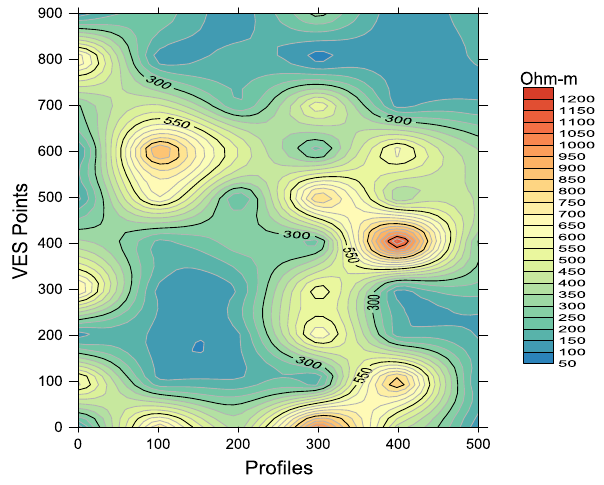
Fig. 6 Iso-resistivity map of the fractured basement